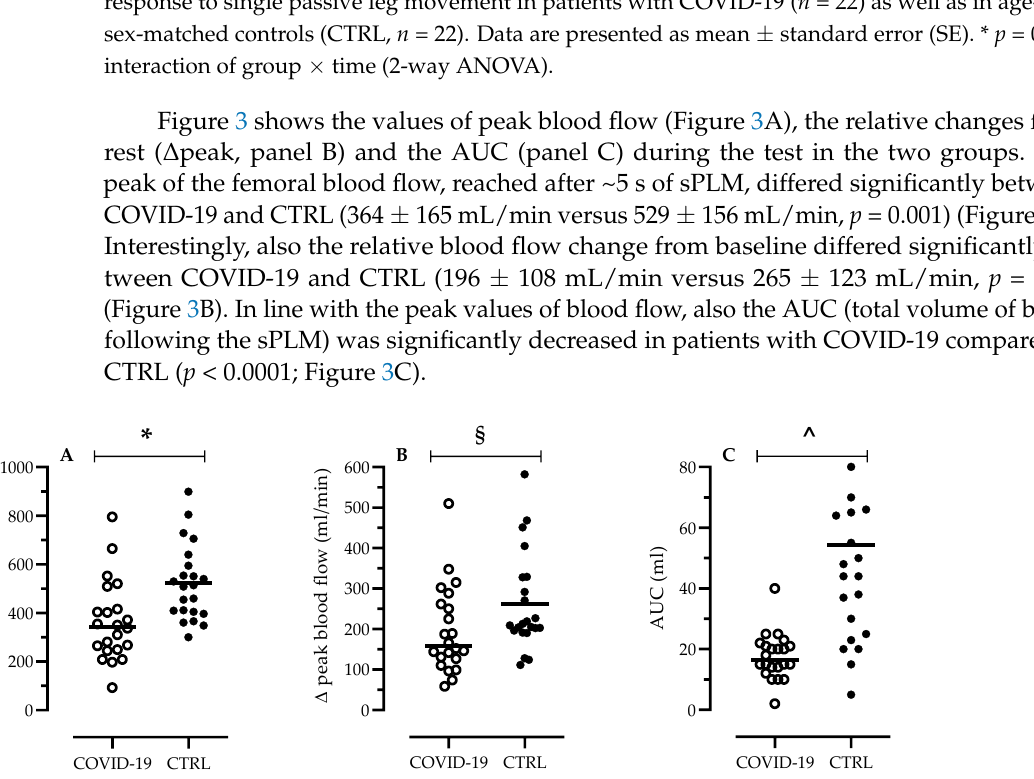
Figure 3. Peak blood flow ( A ), the relative changes from rest ( ∆ peak, B ) and the area under the curve (AUC, C ) during the sPLM in COVID-19 patients ( n = 22) versus age- and sex-matched controls (CTRL, n = 22). Data are presented in a scatter plot, and black bars indicate the mean value; § refers to p = 0.05; * refers to p = 0.001, ^ refers to p < 0.001.